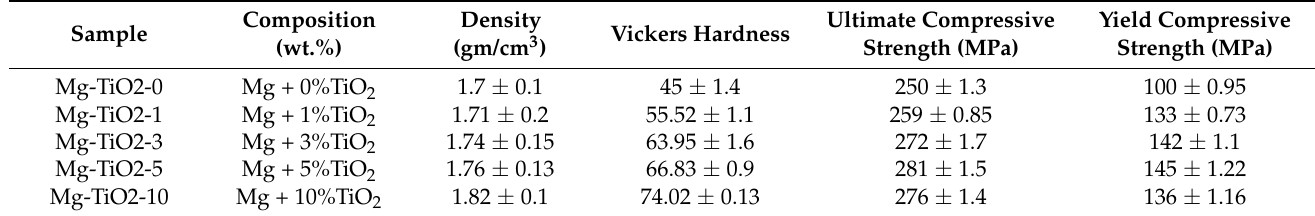
Table 1. The physical and mechanical properties of Mg/TiO 2